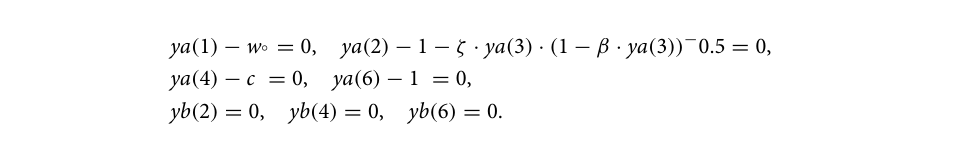
Table 3. Values of Nusselt number k n f K 0.2 and , w N rd =